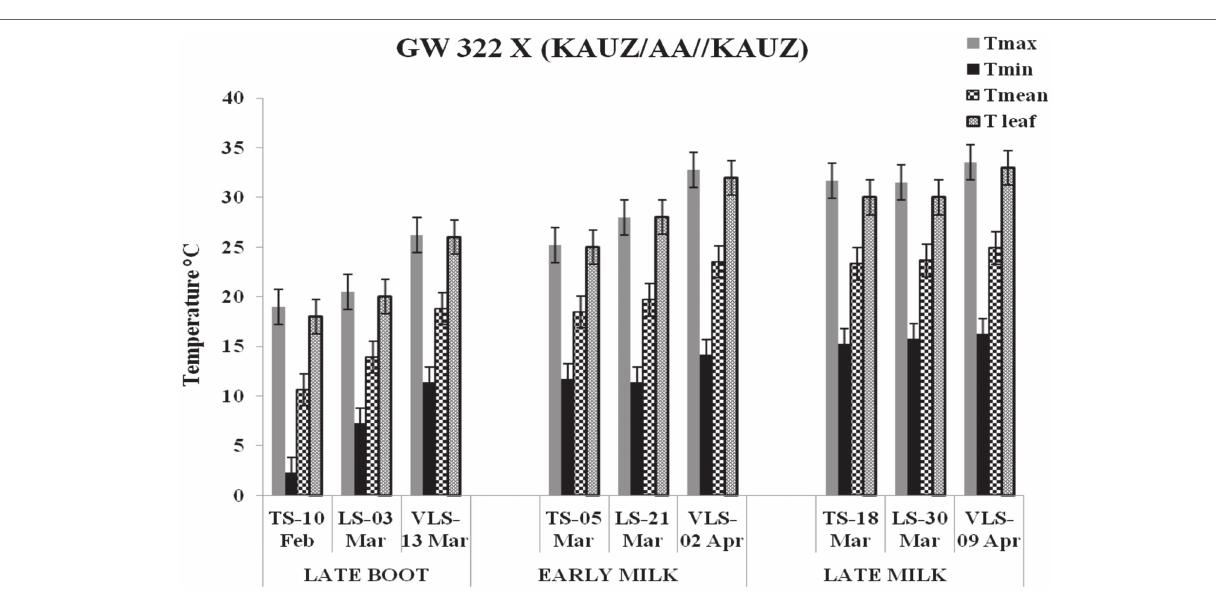
FIGURE 2 | Maximum temperature (Tmax), minimum temperature (Tmin), mean temperature (Tmean), and leaf temperature (Tleaf) in degree Celsius on the date of measuring stomatal conductance at late boot, early milk, and late milk stage under timely sown (TS), late sown (LS), and very late sown (VLS) condition for cross 1—GW 322 X (KAUZ/AA//KAUZ).